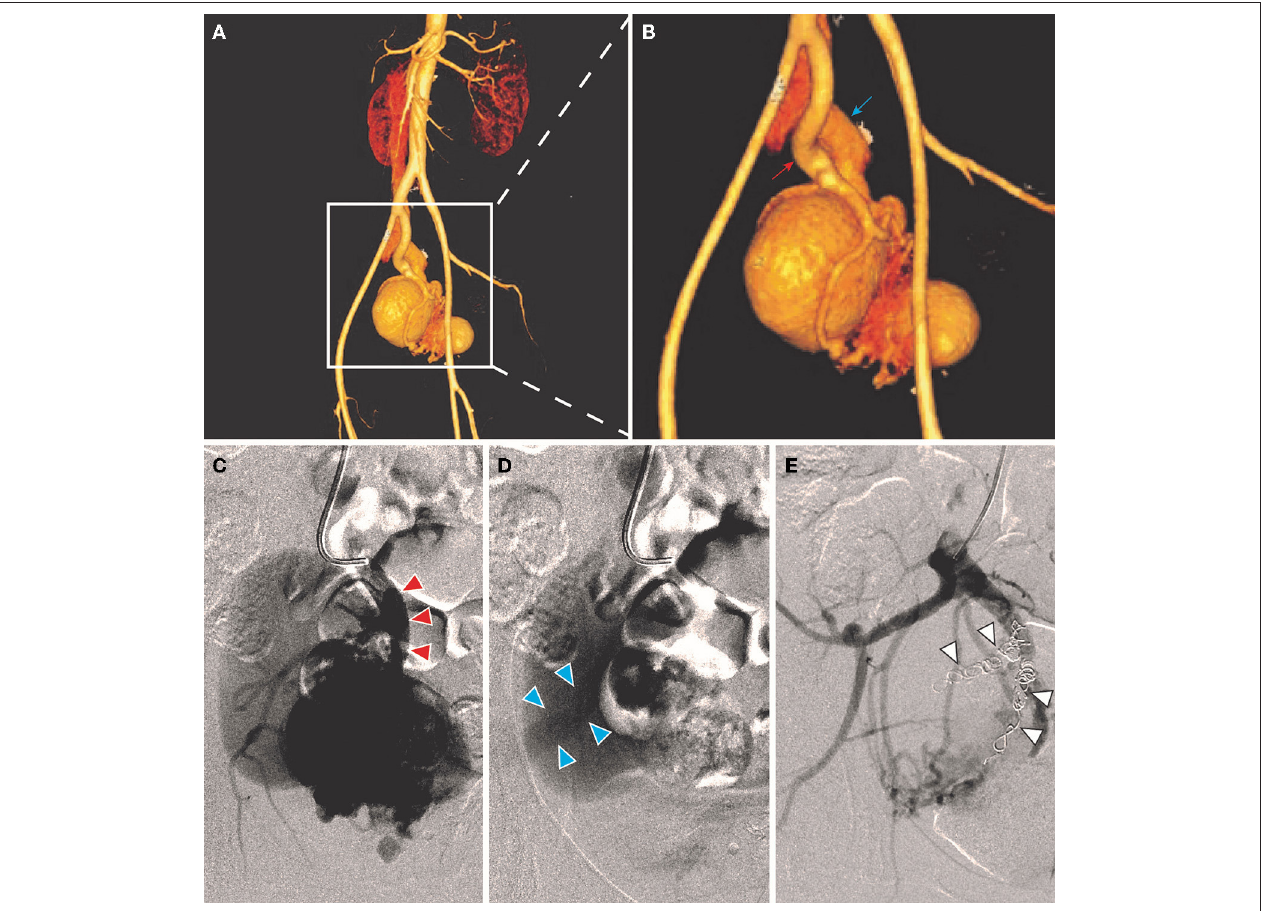
FIGURE 2 | A 36-year-old female (case 2) was diagnosed as IAVFs and treated with transarterial embolization. (A,B) CTA showed communications between right internal artery (red arrow) and vein (blue arrows). (C,D) Transarterial angiography showed inflow arteries (red triangle arrows) and outflow veins (blue triangle arrows). (E) . Coil embolization of branches of right internal iliac artery (white triangle